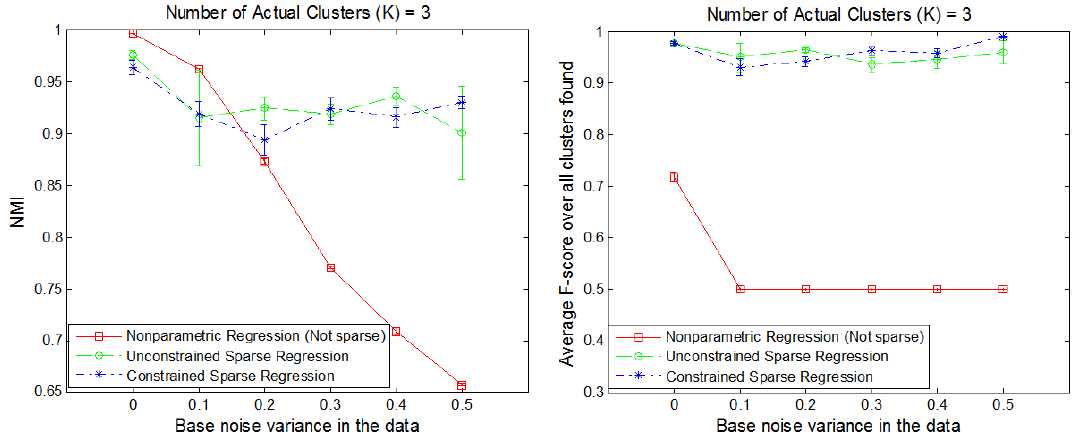
Figure 4. Left panel: ability of nonparametric unregularized and sparse regressions (unconstrained and constrained) to correctly identify clusters (indicated by NMI) with increasing noise. Right panel: ability of nonparametric unregularized and sparse regressions (unconstrained and constrained) to correctly retrieve the sparse structure within each cluster (indicated by average F score).